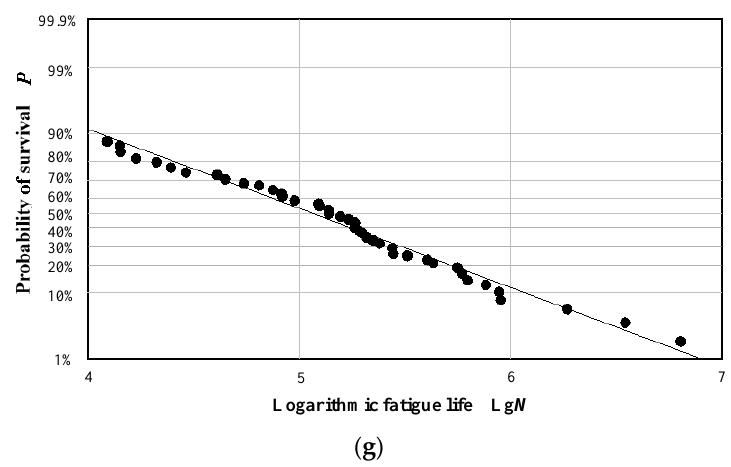
Figure 1. Verification of the normal distribution of fatigue test data: ( a ) butt weld; ( b ) cruciform joints failing in the weld throat; ( c ) plates with transverse fillet-welded attachments; ( d ) plates with longitudinal fillet-welded attachments; ( e ) plates with longitudinal edge gussets; ( f ) fillet-welded joints with longitudinal round pipes; ( g ) base metal.